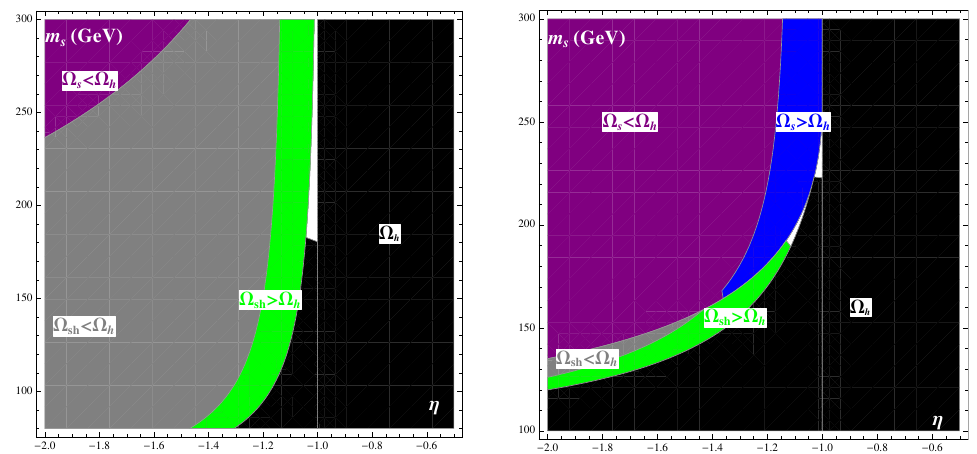
Figure 2 . Tree level vacuum structures at zero temperature in the ( (cid:17); m s ) plane for the case (cid:17) < 0: (Left panel) a smaller (cid:21) sh = 0 : 05 with (cid:21) s = 1; (Right panel) a larger (cid:21) sh = 0 : 27 with (cid:21) s = 1. In each colored region, we label (using the same color, a convention applied to other (cid:12)gures) all the local minima (with number no lager than two) and their relative orders, says in the green regions there are two minima (cid:10) sh and (cid:10) h with the latter the ground